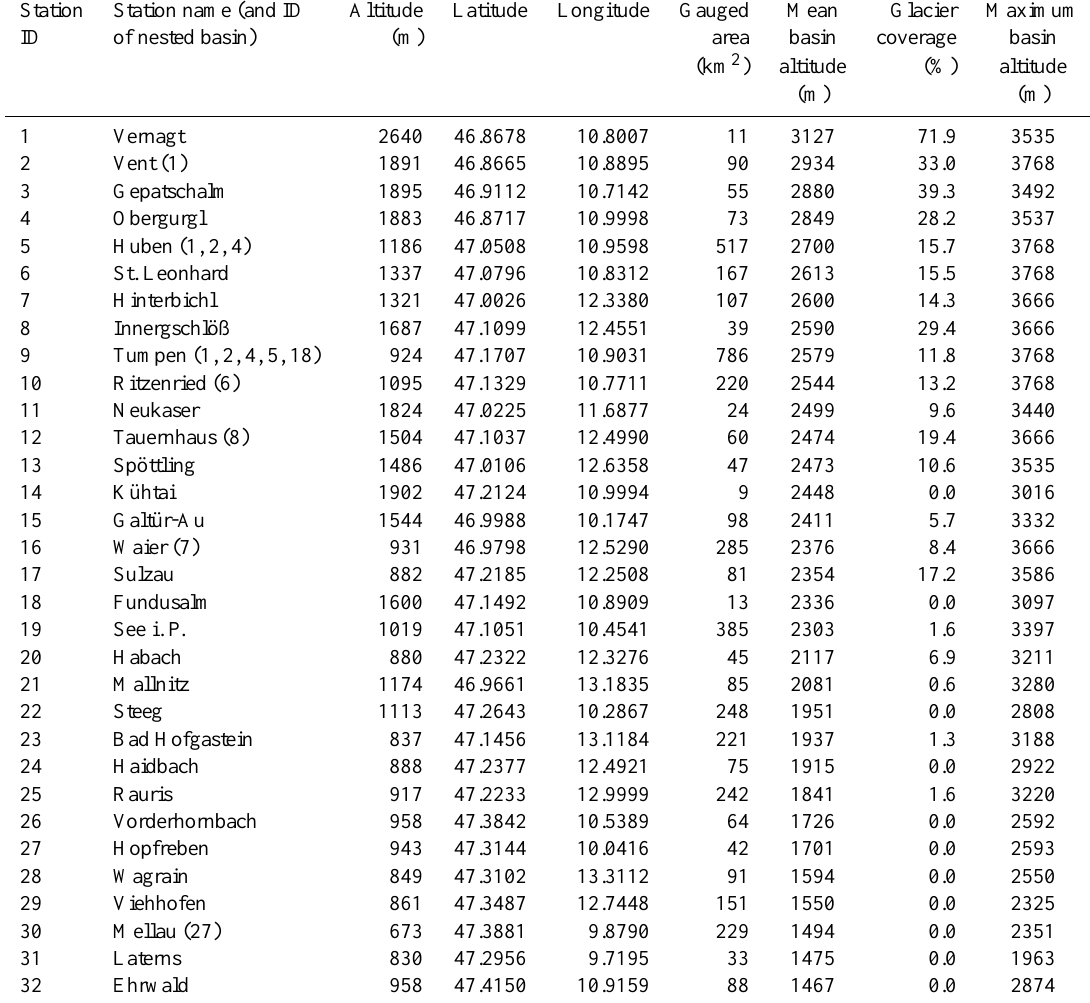
Table 1. List of the gauging stations used in this study (sorted by mean altitude) and their characteristics.